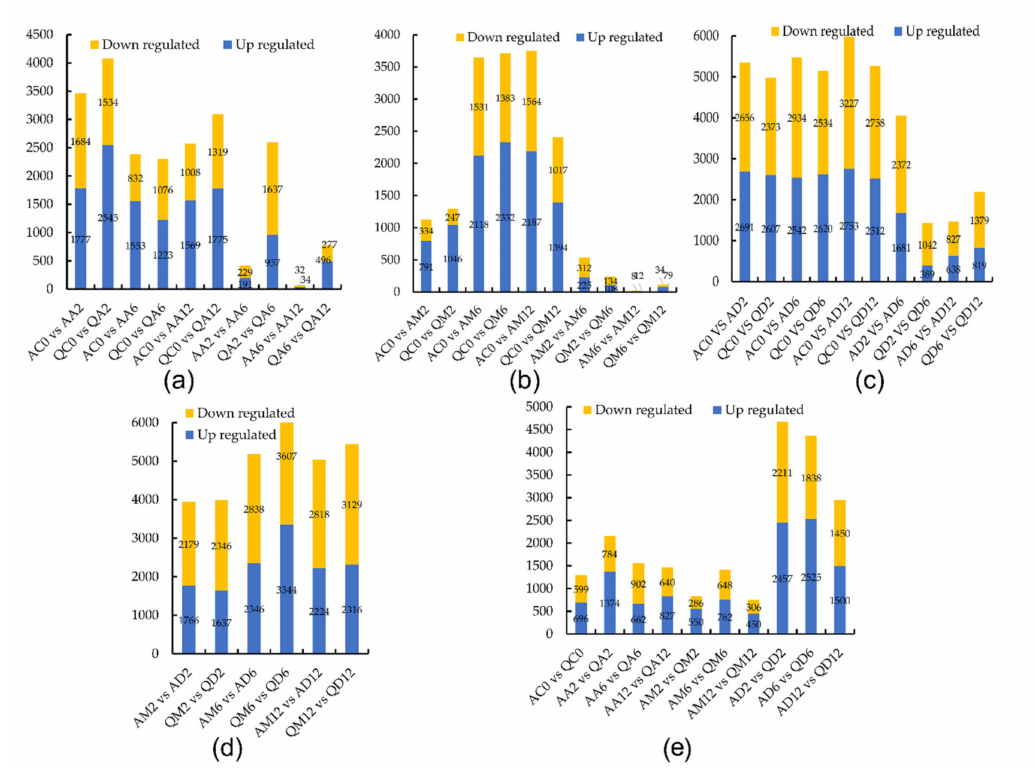
Figure 1. Differentially expressed genes (DEGs) statistics for comparisons. ( a ) Number of DEGs in varieties Atlantic (A) and Qingshu 9 (Q) under methylation inhibitor treatment. ( b ) Number of DEGs in varieties A and Q under simulated drought treatment. ( c ) Number of DEGs in varieties A and Q under dual treatment. ( d ) Number of DEGs in comparison between simulated drought and dual treatment. ( e ) Number of DEGs among varieties A and Q under three